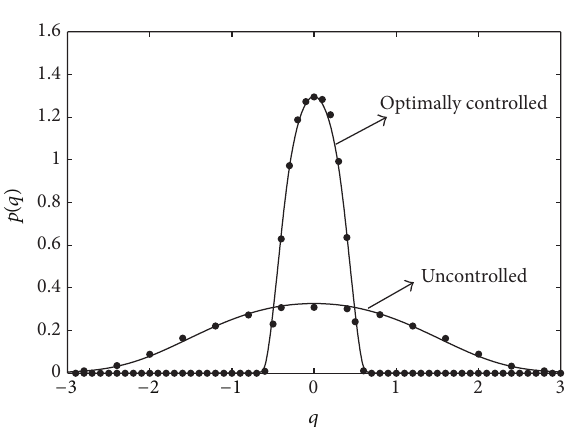
Figure 6: Stationary probability density 𝑝(𝑞) of displacement of uncontrolled and optimally controlled system (40). The lines are obtainedfromnumericalsolutionof(44)whilethedotsareobtained from direct simulation of original system (40).